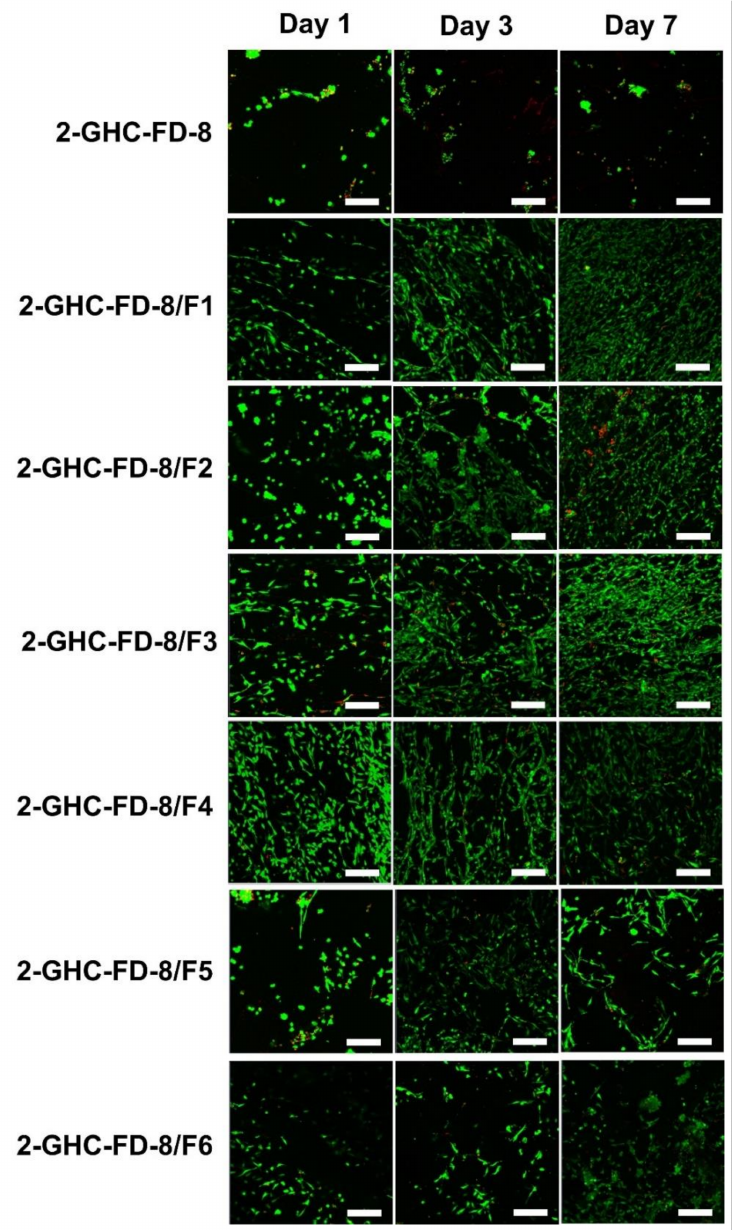
Figure 8. Confocal images of NIH/3T3 cells cultured on 2-GHC-FD-8 and 2-GHC-FD-8/F1-6 for 1, 3, and 7. The green and red colored cells indicate live and dead cells, respectively. White bars indicate 60 µ m. Magnification is 10 ×